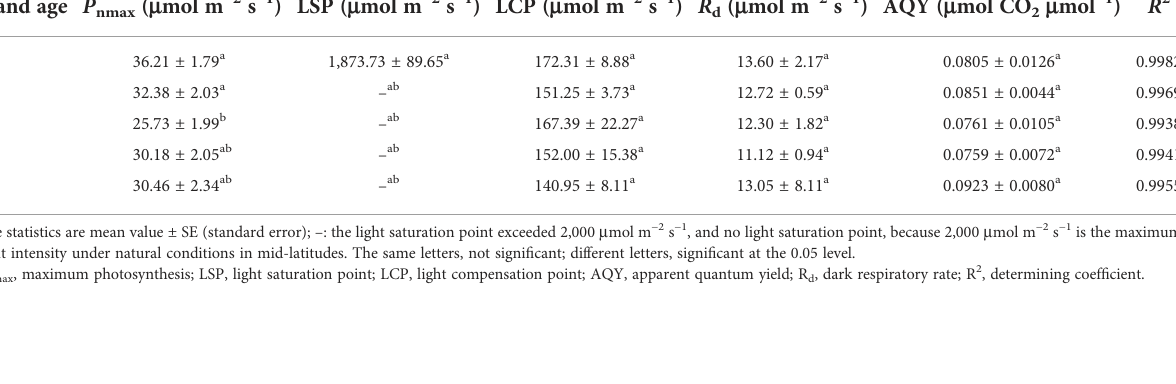
TABLE 3 Statistics of the photosynthetic characteristics of Haloxylon ammodendron at different stand